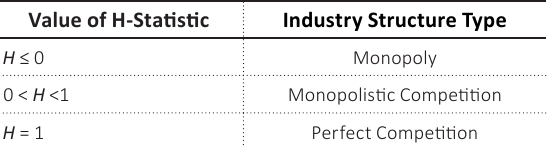
Table 1. Interpretation of the